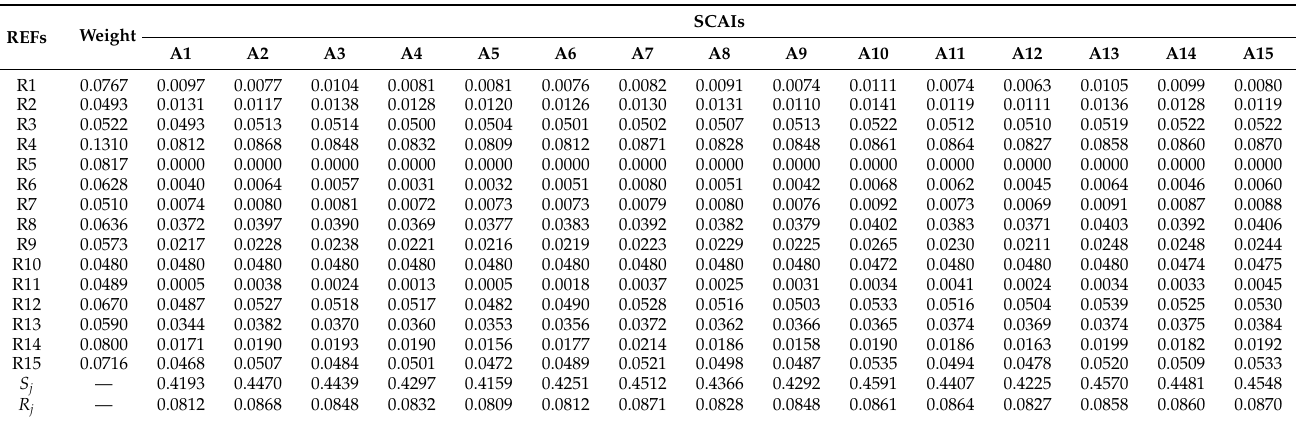
Table 12. Results of group utility S j and individual regret R j